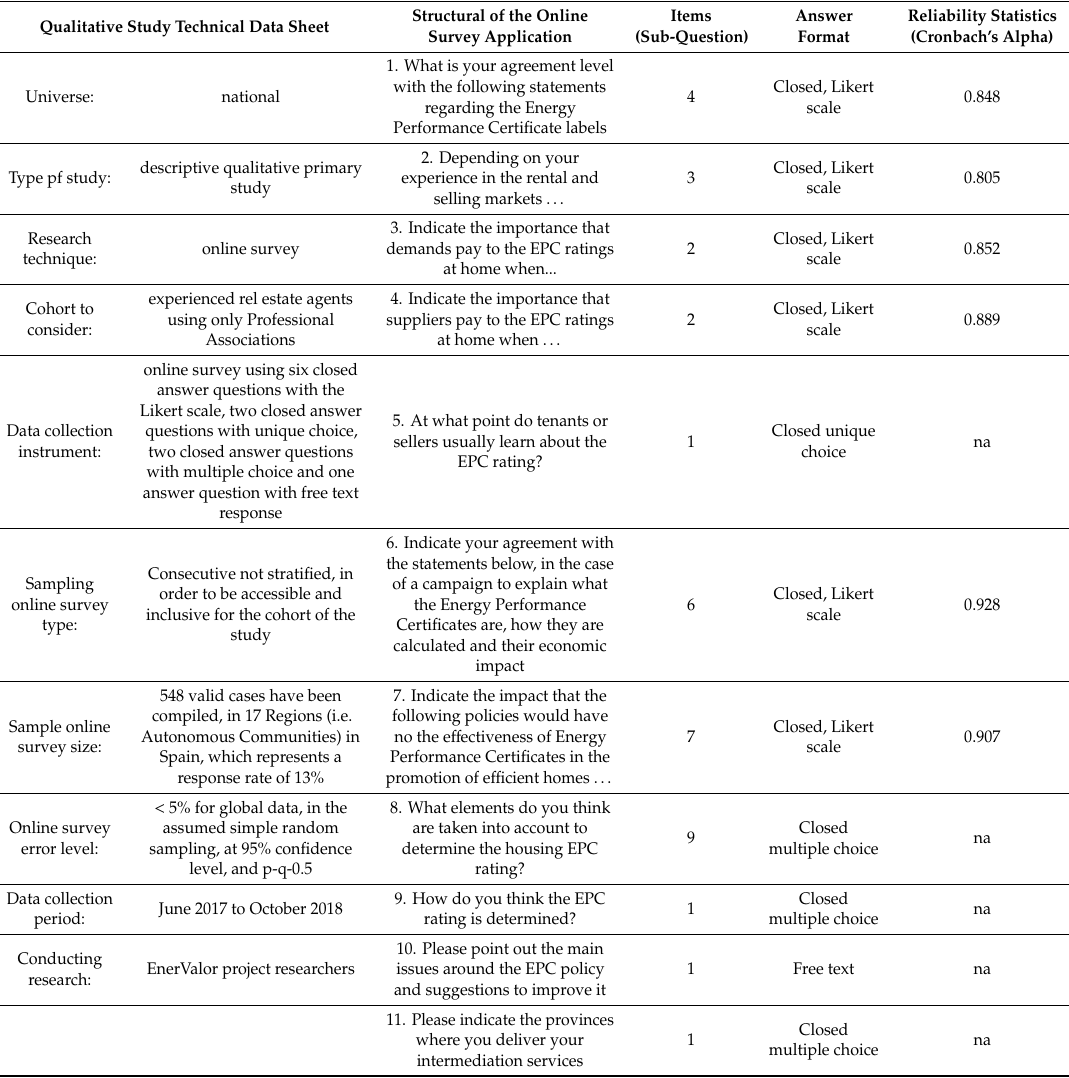
Table 2. Survey’s technical details and